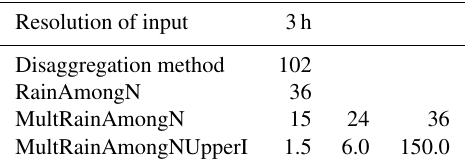
Table A3. Disaggregation for precipitation parameters (see details from Ward et al., 2017, 2018). Rainfall is evenly distributed among RainAmongN subintervals in a rainy interval for different intensity bins. The number of sub intervals over which to distribute rainfall in each interval is given in MultRainAmongN for three intensity bins. The upper limit for each intensity bin to apply MultRainAmongN is given in